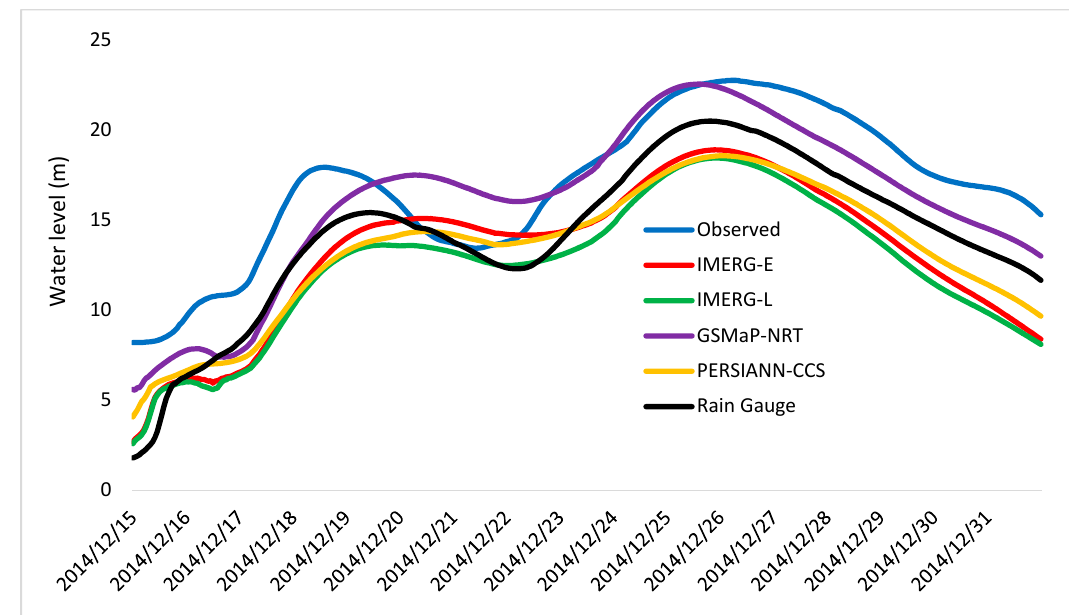
Figure 6. Comparison of hydrograph of observed water level and simulated water levels.